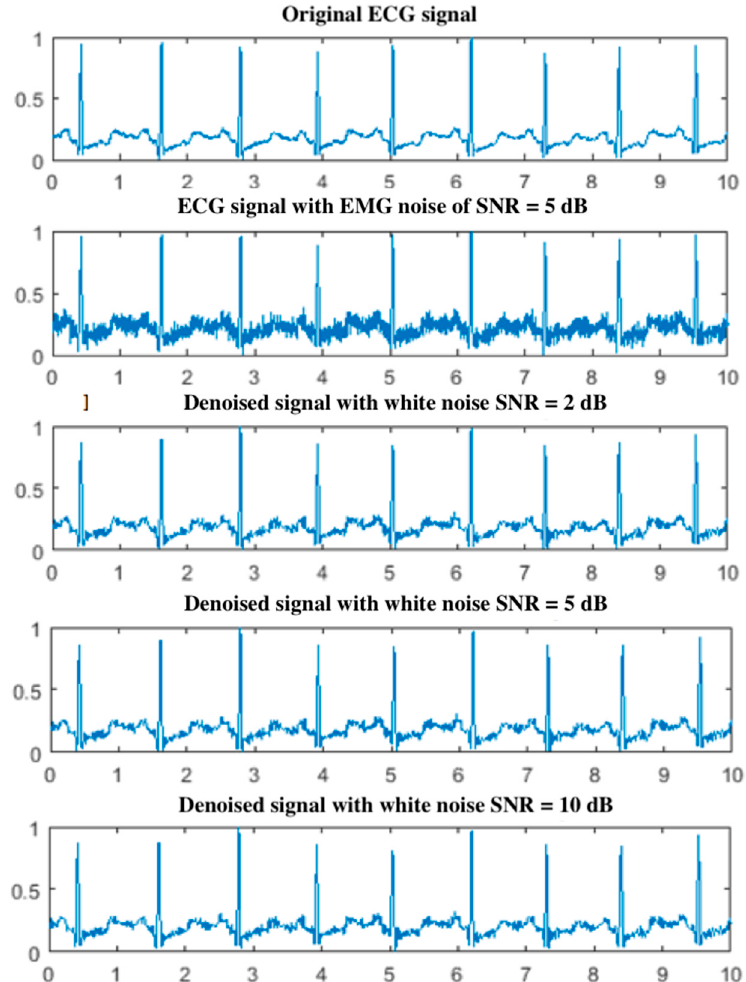
Figure 5. The original ECG signal and ECG signals after the proposed GSNC scheme with different SNR of white noise in the ensemble empirical mode decomposition (EEMD) (EMG noise, SNR = 5 dB